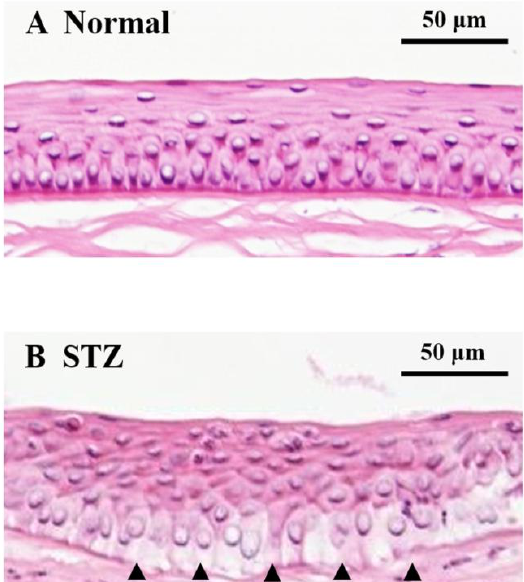
Figure 6. Hematoxylin and eosin staining of the cornea in normal and STZ rats 25 h after corneal wound abrasion. ( A ) Corneal epithelial image of normal rats. ( B ) Corneal epithelial image of STZ rats. Arrow ( ▲ ) shows adhesion deficiency between corneal basal cells and Bowman’s membrane.